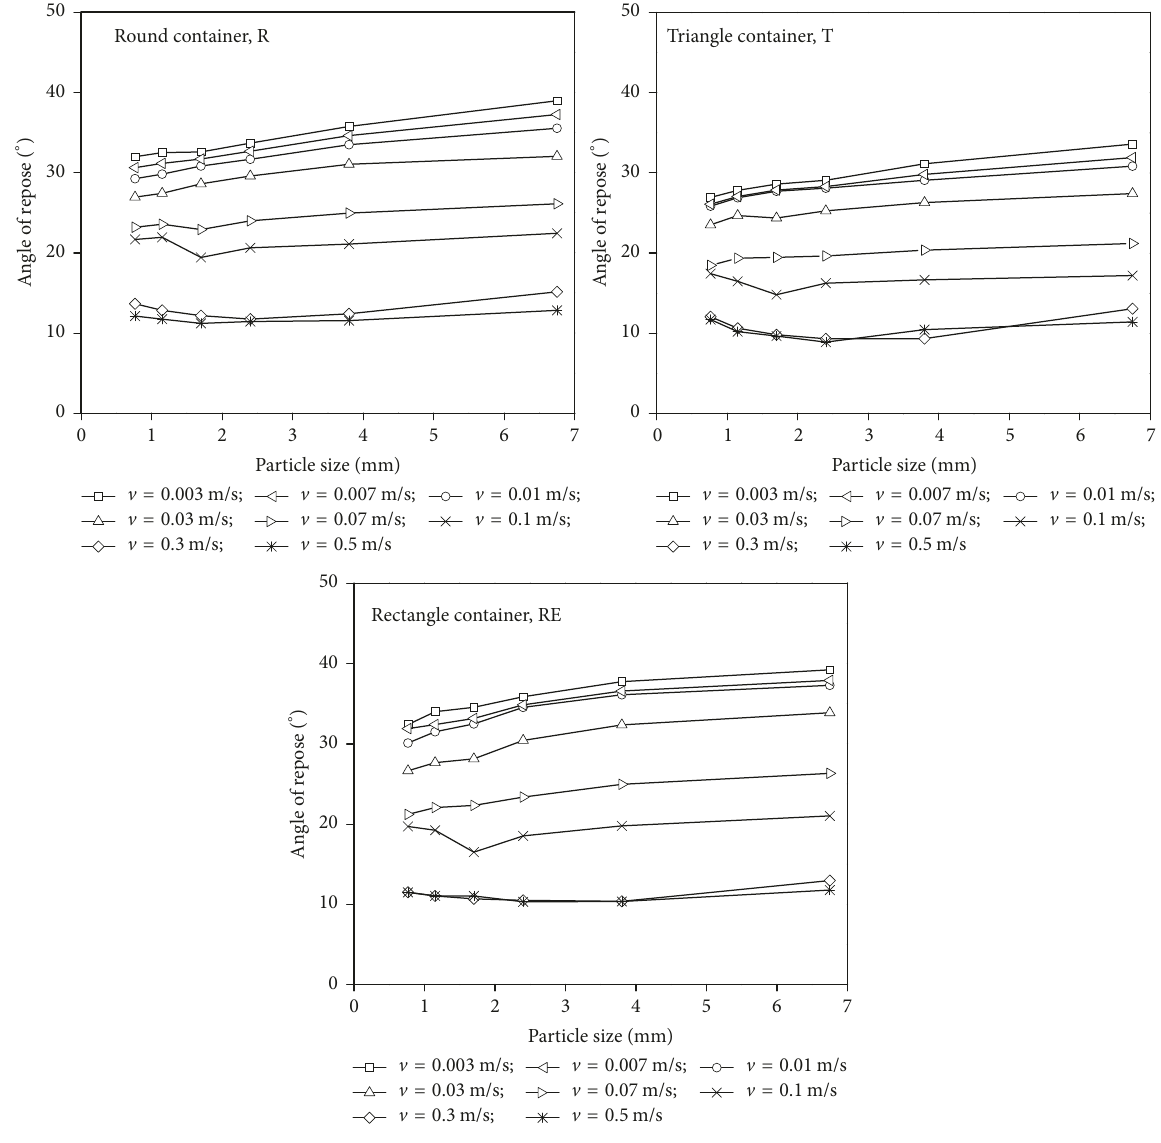
Figure 5: The impact of particle size on angle of